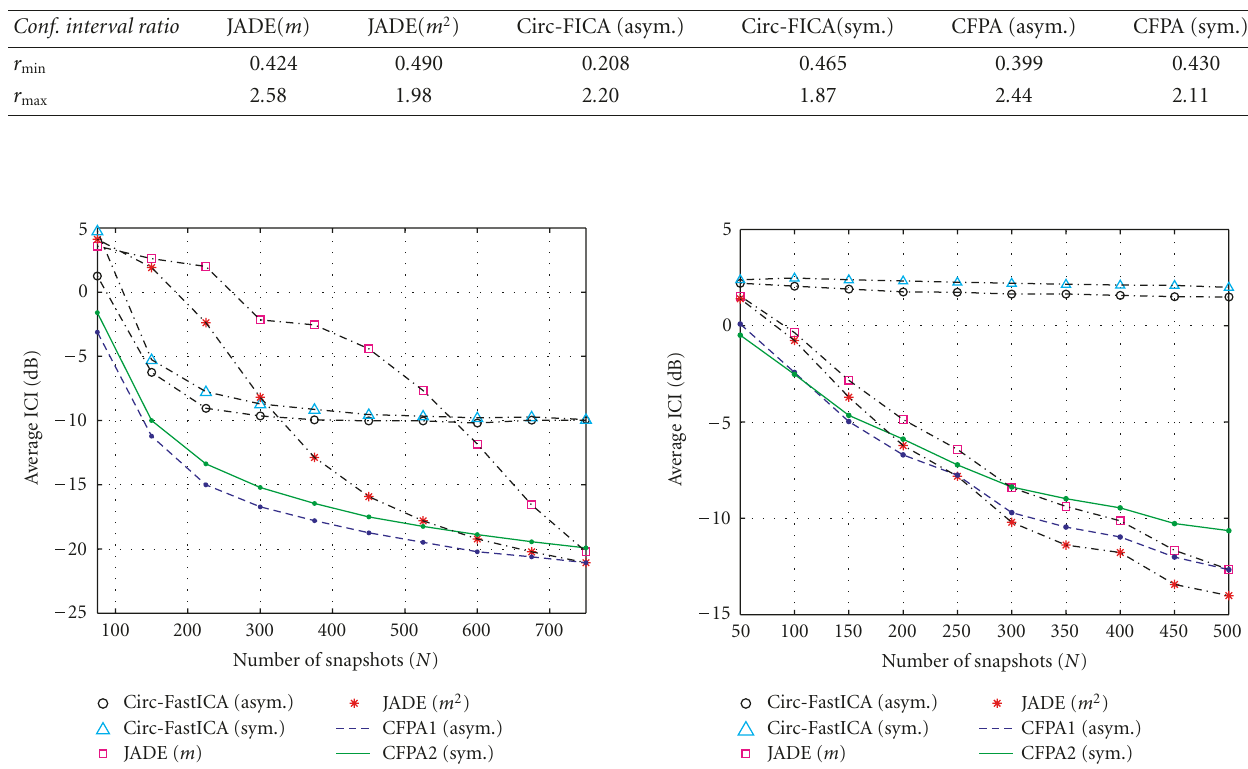
Figure 3: Average ICI as a function of data-record length N for the various algorithms on a noisy i.i.d. source separation